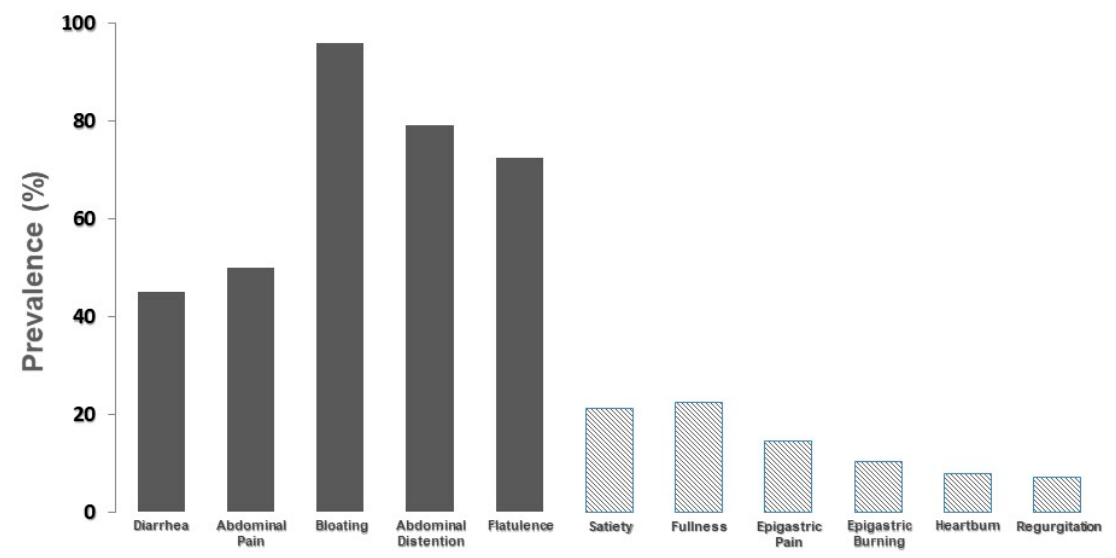
Figure 2. Prevalence of moderate-to-severe symptoms attributed to the ingestion of lactose by the group of 268 patients. Grey bars indicate intolerance-related symptoms; bars with diagonal lines indicate dyspeptic- and reflux-related symptoms.